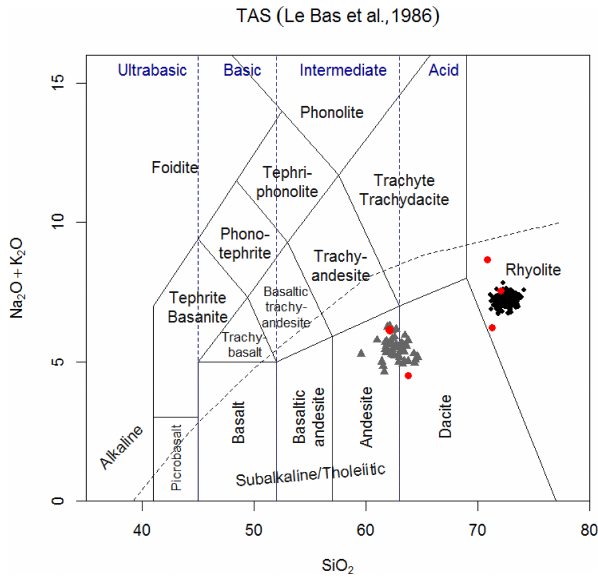
Figure 8. Classification diagram TAS (Le Bas et al., 1986). Ma- jor element compositions of glass shards from the 2015CE Cal- buco eruption acquired by electron microprobe analyses (micro- probe housed at the LAMARX laboratory, FAMAF, Universidad Nacional de Córdoba, Argentina) from samples collected during direct ashfall events in Junín de los Andes and on Cardenal An- tonio Samoré Pass, Argentina (Villarosa et al., 2016), and from the 2011CE Cordón Caulle eruption acquired by electron microprobe (EMP) analysis, with samples collected in San Carlos de Bariloche, Villa La Angostura and on Cardenal Antonio Samoré Pass, Ar- gentina (Alloway et al., 2015). Red circles: EDS analyses from PM samples from the studied area. Glass shards derived from Cordón Caulle (black circles) are rhyolitic in composition, while glass from the Calbuco eruption (grey triangles) is andesitic to dacitic in com-